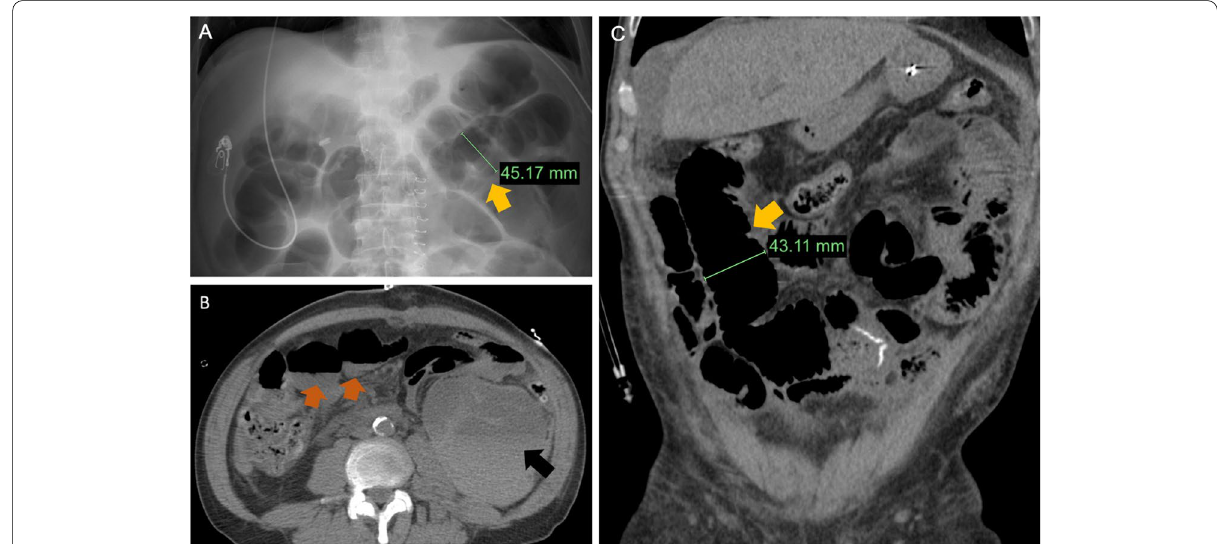
Fig. 1 Initial imaging with abdominal plain film demonstrated dilated loops of bowel measuring over 4 cm in diameter representing ileus versus an obstruction ( A ). This was confirmed on cross-sectional computed tomography imaging without contrast. On axial ( B ) and coronal ( C ) images showing dilated loops of small bowel measuring up to 4.3 cm (filled yellow arrows) with multilevel differential air fluid levels (filled orange arrows) consistent with small bowel obstruction (SBO). A left abdominal soft tissue mass lesion was observed in the left renal fossa. (filled black